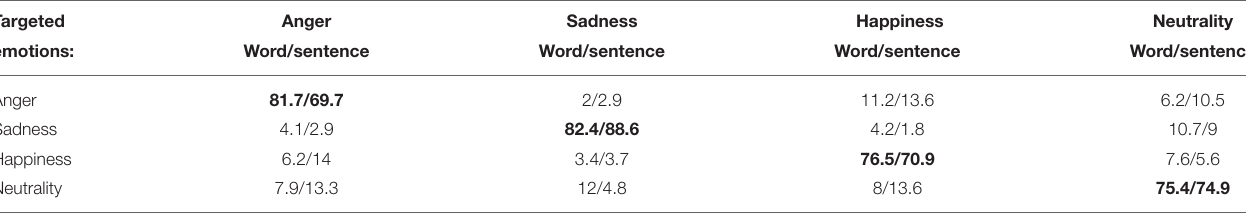
TABLE 2 | Accuracy level for differing emotions within word vs . sentence model. Targeted